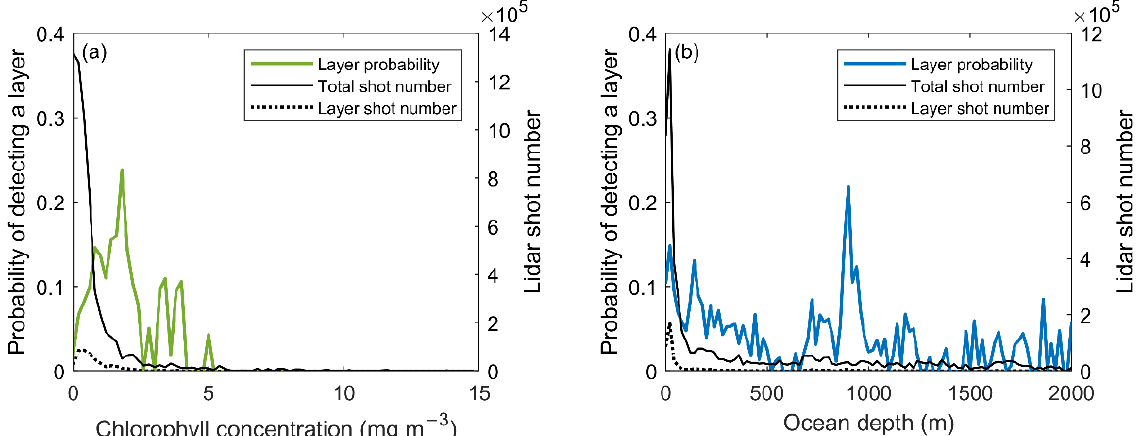
Figure 6. ( a ) Probability of occurrence of thin layers of phytoplankton at different sea surface chlorophyll concentrations; ( b ) Probability of occurrence of thin layers of phytoplankton at different ocean depths.